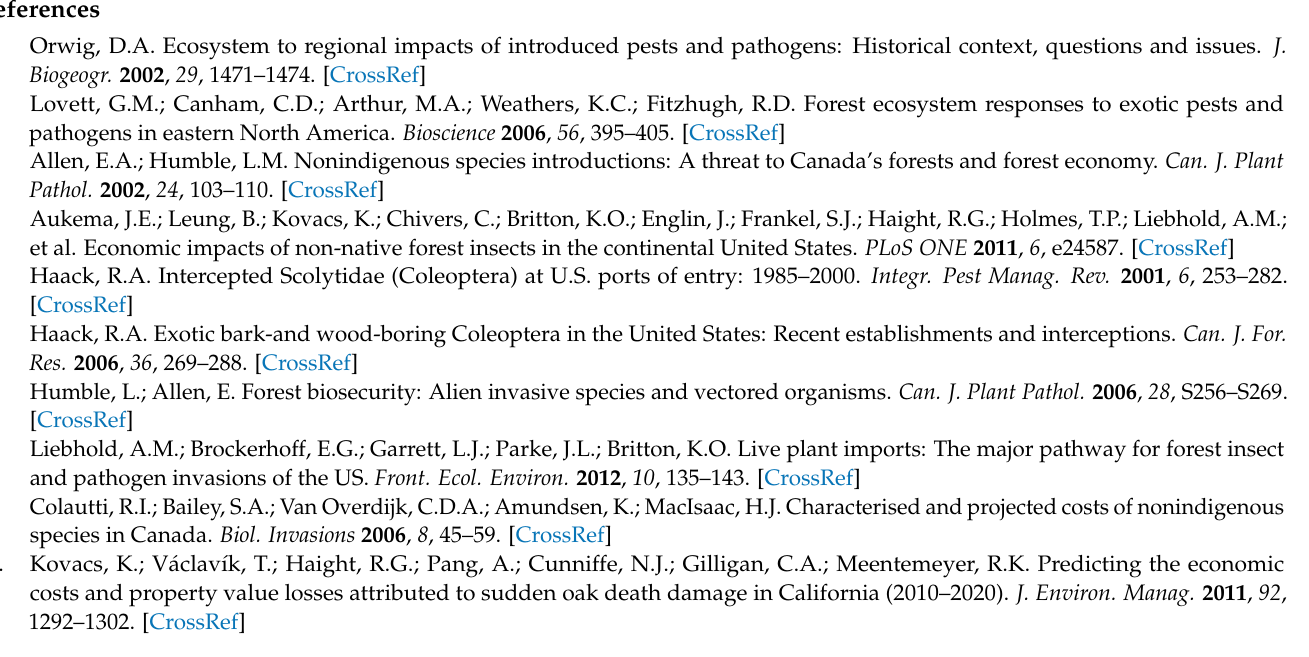
Figure S2: Correlations among bioclimatic variables extracted from occurrence data (presence and pseudo-absence data) of Ips typographus . Black squares indicate (cid:36) < |0.70|. Figure S3: Correlations among bioclimatic variables extracted from occurrence data (presence and pseudo-absence data) of Endoconidiophora polonica . Black squares indicate (cid:36) < |0.70|. Table S1: A non-exhaustive list of primary or potential host tree species, and their distributions, of the European spruce bark beetle ( Ips typographus ) and the associated blue stain fungal pathogen Endoconidiophora polonica . Table S2: A generalized linear model associating climatic and topographic variables with occurrences of Ips typographus in Eurasia (n presences = 237; n pseudo-absences = 237). Table S3: A generalized linear model associating climatic and topographic variables with occurrences of Endoconidiophora polonica in Eurasia (n presences = 45; n pseudo-absences =